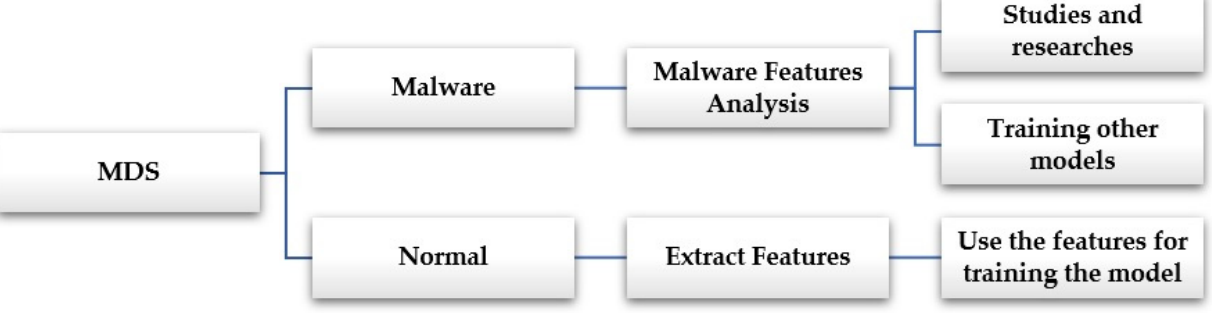
Figure 13. Normal and Malware features analysis on MDS.